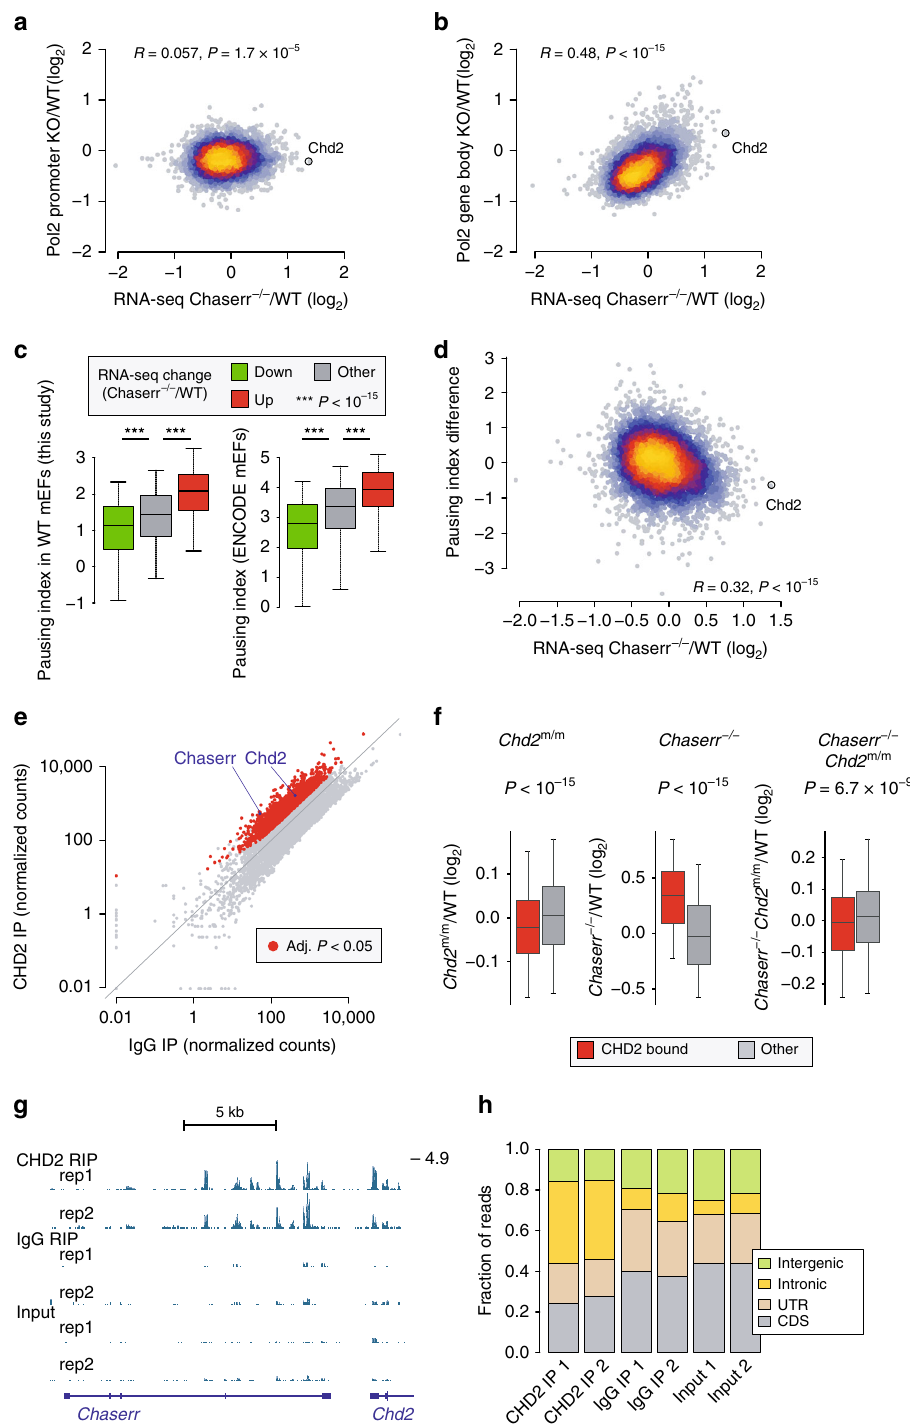
Fig. 6 Changes in Pol2 occupancy in Chaserr – / – mEFs and RNA binding by CHD2. a Correlation between changes in gene expression levels and changes in Pol2 occupancy at the promoter region (±300 bases around TSS). Color indicates point density. b As in a , but for changes in Pol2 occupancy at gene body regions (de fi ned from 1 kb downstream of the TSS to the TTS). c Pol2 pausing index (see the “ Methods ” section) in our WT mEF Pol2 ChIP-seq data (left) and ENCODE mEF data (right) for genes with the indicated changes in gene expression in Chaserr − / − mEFs (adjusted P < 0.05). Boxplots show the 5th, 25th, 50th, 75th, and 95th percentiles. d Changes in Pol2 pausing index as a function of changes in gene expression between Chaserr − / − and WT mEFs. Color indicates point density. e Normalized RIP-seq read counts within gene bodies in CHD2 and IgG RIP libraries (average of two replicates). Red dots correspond to genes with adjusted P < 0.05 (DESeq2 analysis). f Changes in gene expression of genes signi fi cantly associated with CHD2 (from e) and other genes expressed in mEFs in the indicated RNA-seq-based comparison. Boxplots show the 5th, 25th, 50th, 75th, and 95th percentiles. g RIP-seq read coverage in the Chaserr locus. h Fractions of reads mapping to the indicated regions in the indicated RIP-seq library. Source data are provided as a Source Data fi le